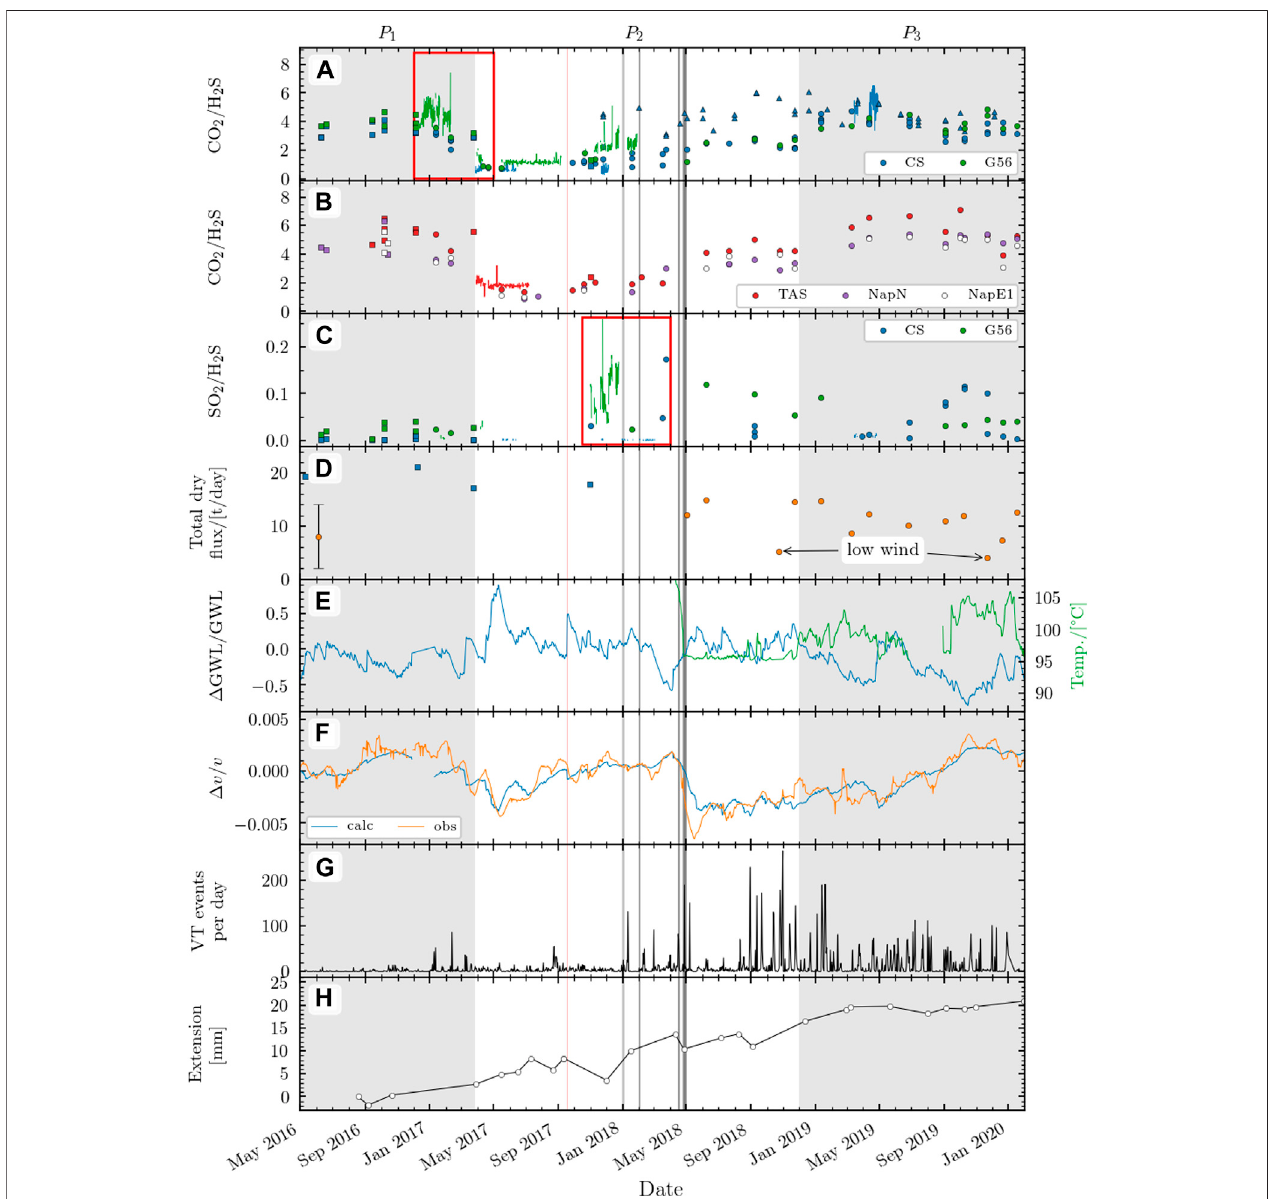
FIGURE4| TimeseriesofvolcanomonitoringforLaSoufrièresince2016. (A – D) MultiGasdata: (A,B) MolarCO 2 /H 2 Sratiosforfourmainfumarolicvents, (C) Molar SO 2 /H 2 S ratios only for CS and G56, (D) Total dry gas fl uxes (CO 2 +SO 2 + H 2 S fl uxes at CS, G56 and TAS). MultiGas square data are from Tamburello et al. (2019). (E) Groundwater table level (m) along with temperature ( ° C) (F) Relative velocity fl uctuations dV/V, observed and calculated. (G) Seismic activity showing volcanic tectonic (VTs) counts per day. (H) extensometry data for NAP1 (m). Three different periods (P1, P2, P3) of chemical variations are identi fi ed. Major VTs are marked in grey and Maria hurricane in red line. Both red insets are periods focused in Figure 5 .